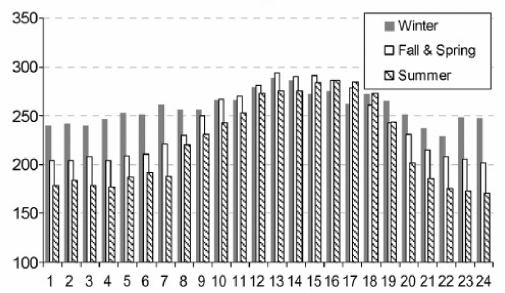
Figure 2. Daily patterns for hourly average power generation for a 500-kW wind turbine [10].